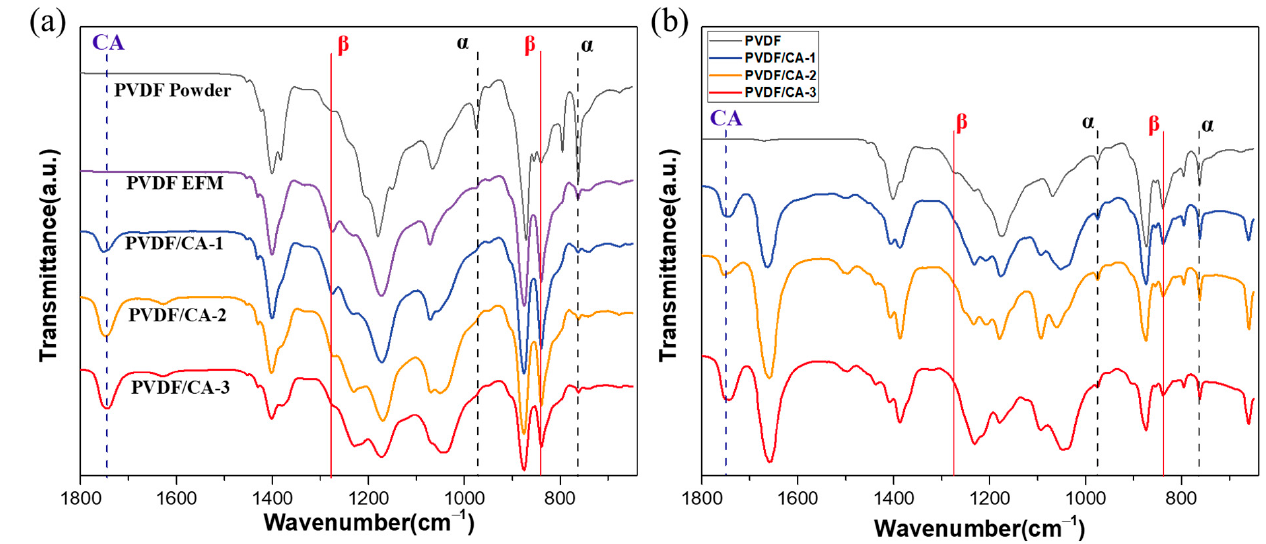
Figure 5. FTIR spectra of ( a ) PVDF powder and PVDF/CA EFMs, and ( b ) PVDF/CA cast film. In addition, assuming that the infrared absorption peaks obey the Lambert–Beer law, the content of β -phase in PVDF could be obtained from the following equation [36]: